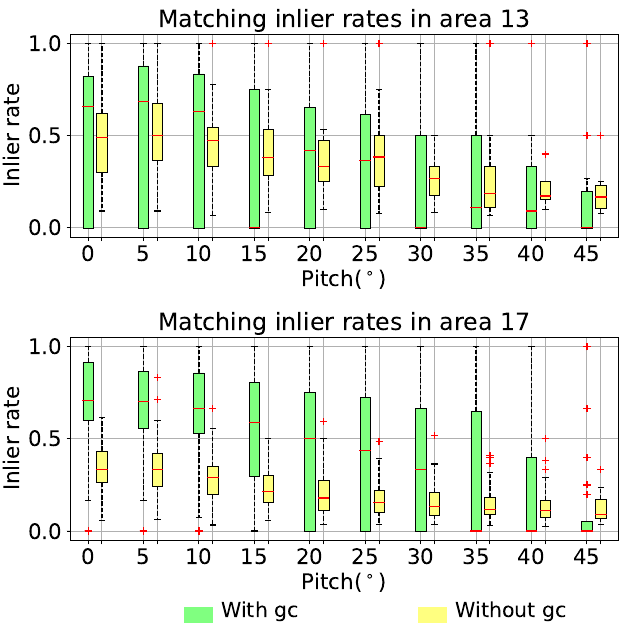
Figure 7. Inlier rates of correspondences for each aerial image before (without gc) and after (with gc) graph-cut optimization under different viewing